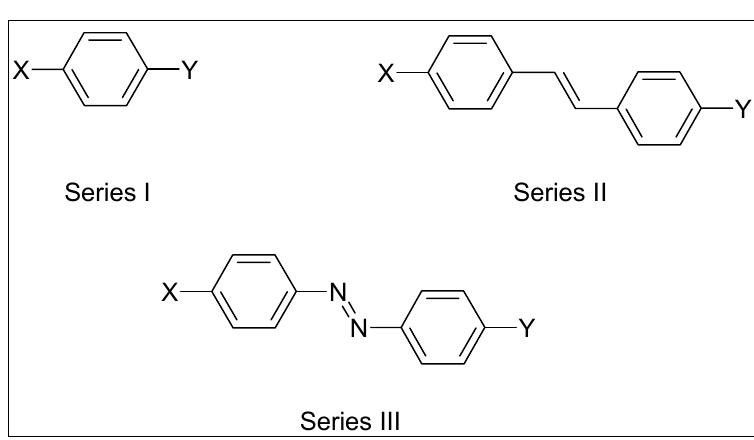
Figure 2 . Molecules